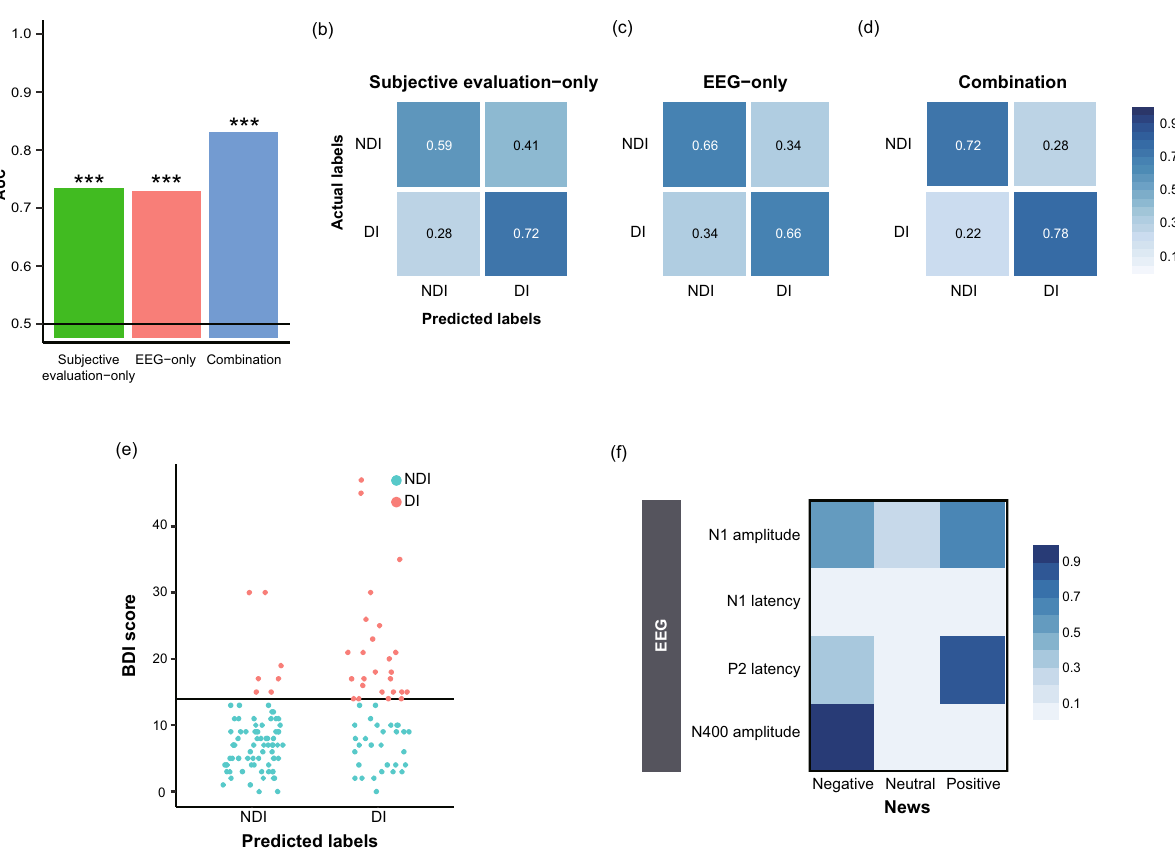
Figure 5. Classifications of individuals’ states based on the EEG and/or subjective evaluation. ( a ) AUC values of classification based on the Subjective evaluation-only features, EEG-only features, and the Combination features (*** p < 0.005). The confusion matrix of classification results based on ( b ) subjective evaluation-only features, ( c ) EEG-only features, and ( d ) combination features. Since the matrix values represent the ratio of the number of predicted labels to the total number of participants in the non-depressed individuals (NDI) and depressed individuals (DI) for each row, the diagonal components of the confusion matrices represent true negative rate (TNR) and true positive rate (TPR), respectively. ( e ) Number of participants in the NDI and DI per predicted label; the y-axis represents the BDI-II score of the participant. ( f ) The mean absolute coefficients value of each feature in the EEG-only features. For visibility, the coefficient values were normalized to have a range of [0,